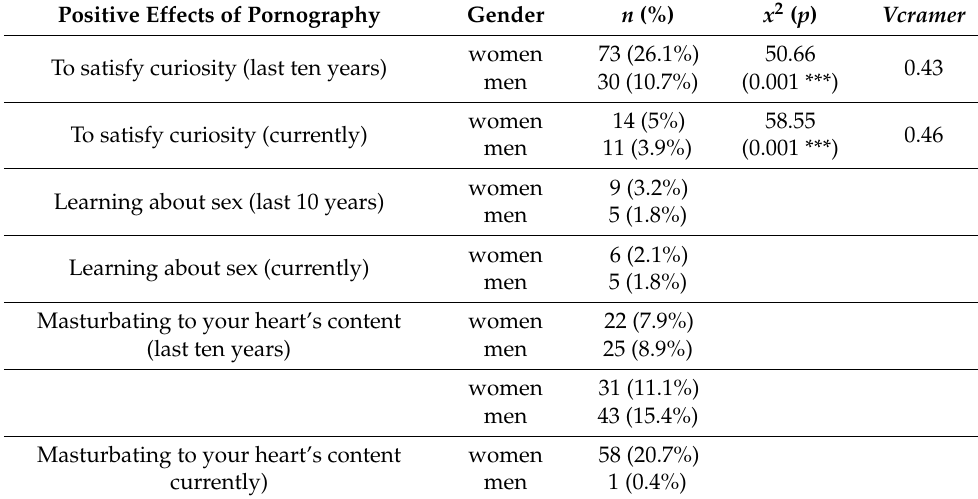
Table 4. Positive effects that are valued most as a function of